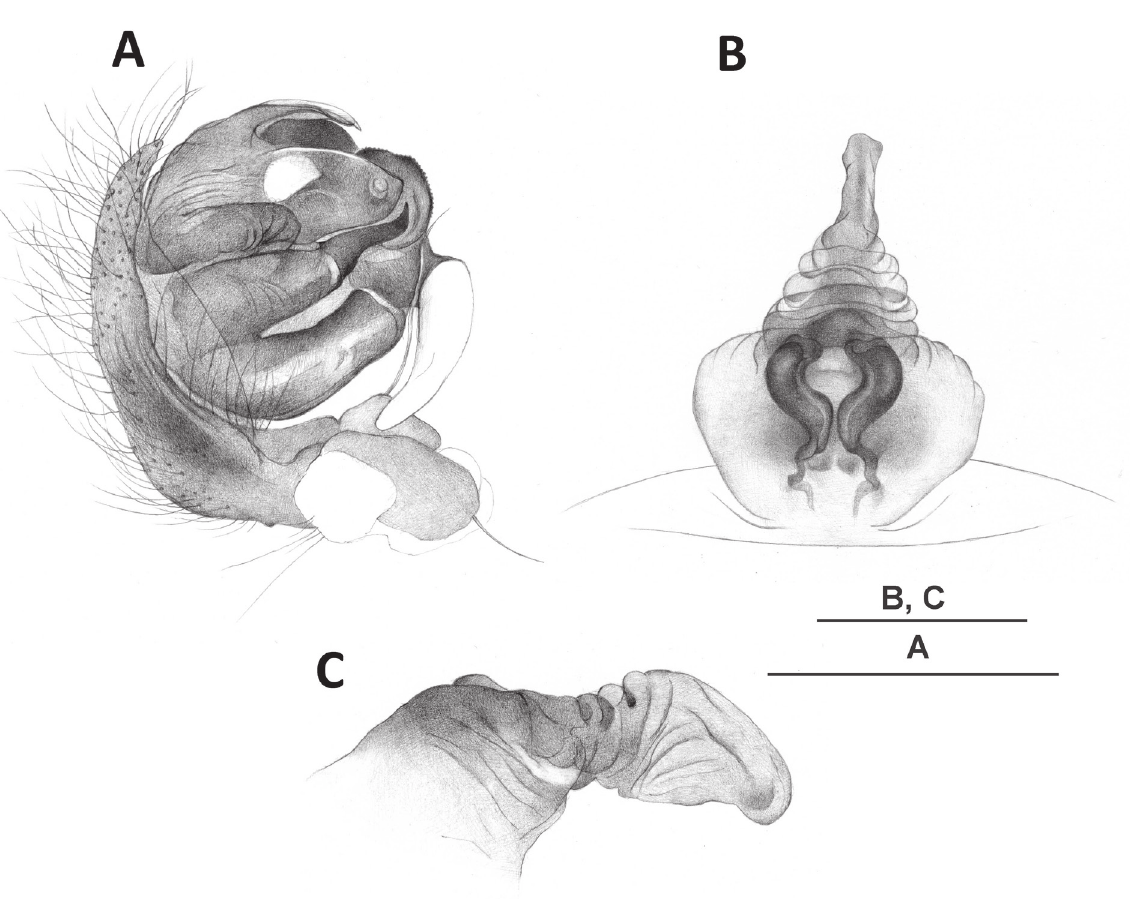
Fig. 4. Eustala meridionalis sp. nov. A . ♂ left palp, ventral view. B . ♀ epigyne scapus, ventral view. C . ♀ scapus, lateral view. Scale lines = 0.5